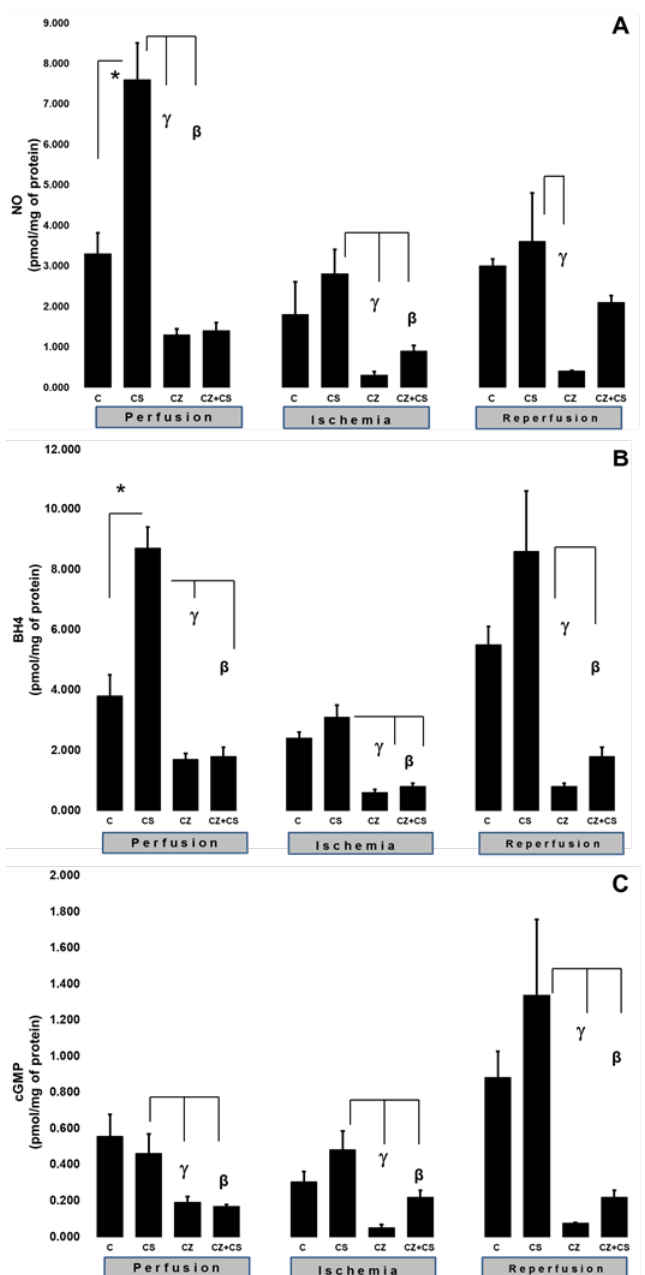
Figure 3. Levels in cardiac tissue of NO ( A ), BH4 ( B ) and cGMP ( C ). Isolated hearts were perfused in three conditions: perfusion (30 min), ischemia (30 min) and reperfusion (60 min). Hearts were obtained from control rats and treated with CS, CZ and CZ+CS. Ventricular tissue samples were obtained at the end of reperfusion. Values are the mean ± SE ( n = 5 in each group p ≤ 0.05).* C vs. CS; γCS vs. CZ; βCS vs. CZ+CS.